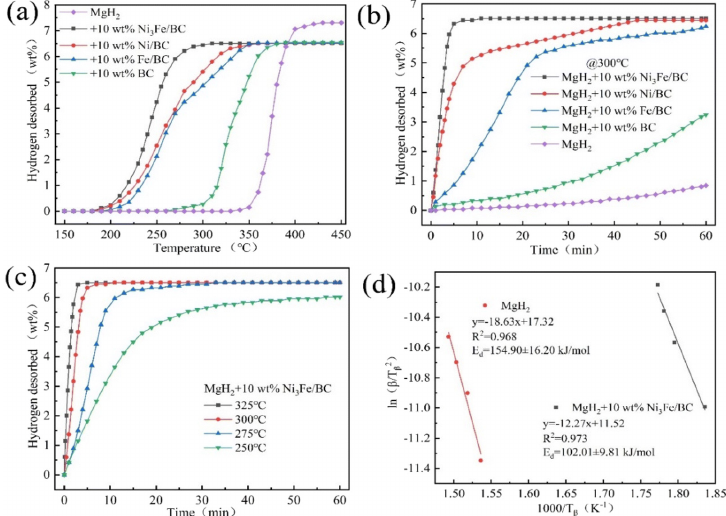
Figure 6. Rising temperature dehydrogenation ( a ) and isothermal dehydrogenation ( b ) curves of pure MgH 2 and MgH 2 with 10 wt.% of different catalyst samples, isothermal dehydrogenation curves of MgH 2 + 10 wt.% Ni 3 Fe/BC composites at different temperatures ( c ), and Kissinger plots of MgH 2 and MgH 2 + 10 wt.% Ni 3 Fe/BC ( d ). Copyright 2022, Royal Society of Chemistry. Reproduced with permission from [91].